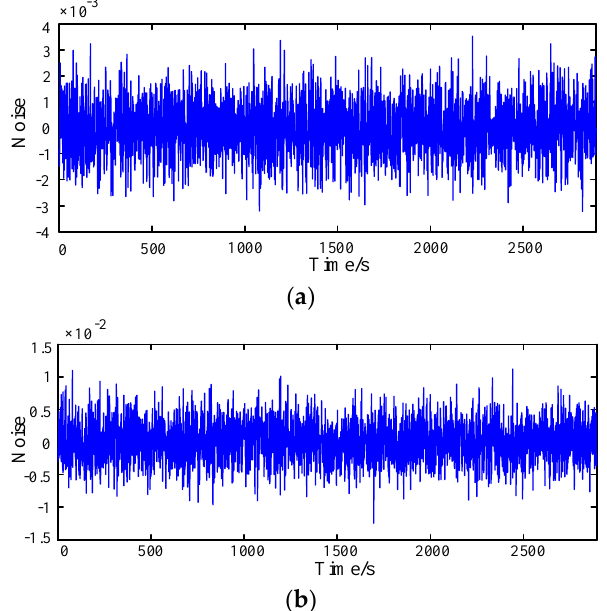
Figure 6. Non-Gaussian noise schematic: ( a ) state noise; ( b ) measurement noise.